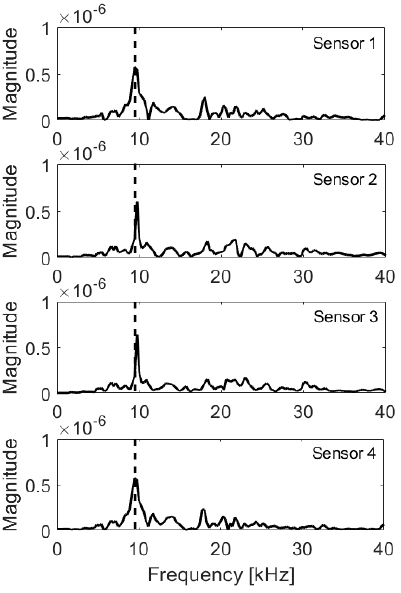
Figure 14. Frequency spectra, edge 5 cm from impactor; expected frequency marked with dashed line. Table 7. Integral and RMS of frequency spectrum, edge below impactor.